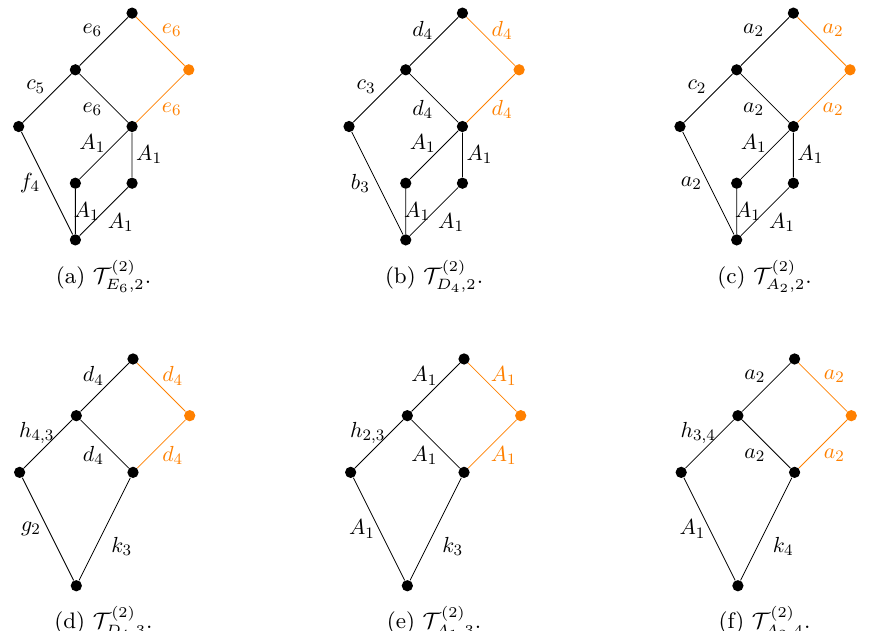
theories. The slice k is detailed in (C.6). These are n G,‘